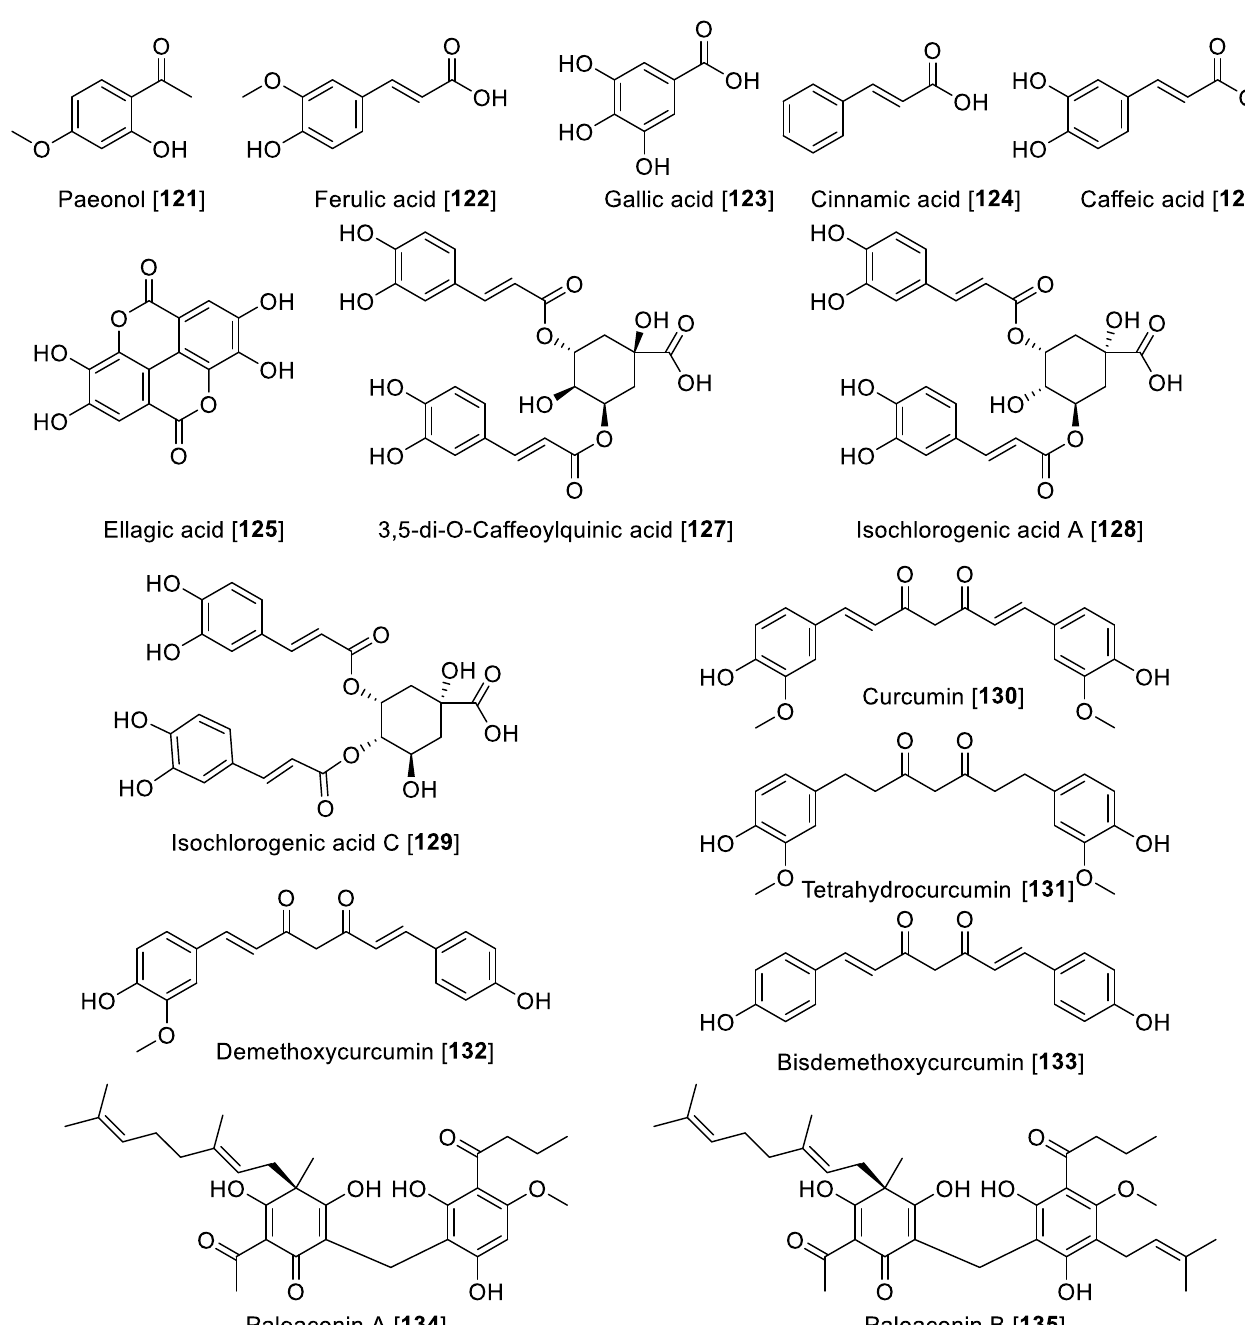
Figure 12. Chemical structure of miscellaneous polyphenol MAO inhibitors. Table 6. Phenol and polyphenolic natural product inhibitors of MAO-A and MAO-B.